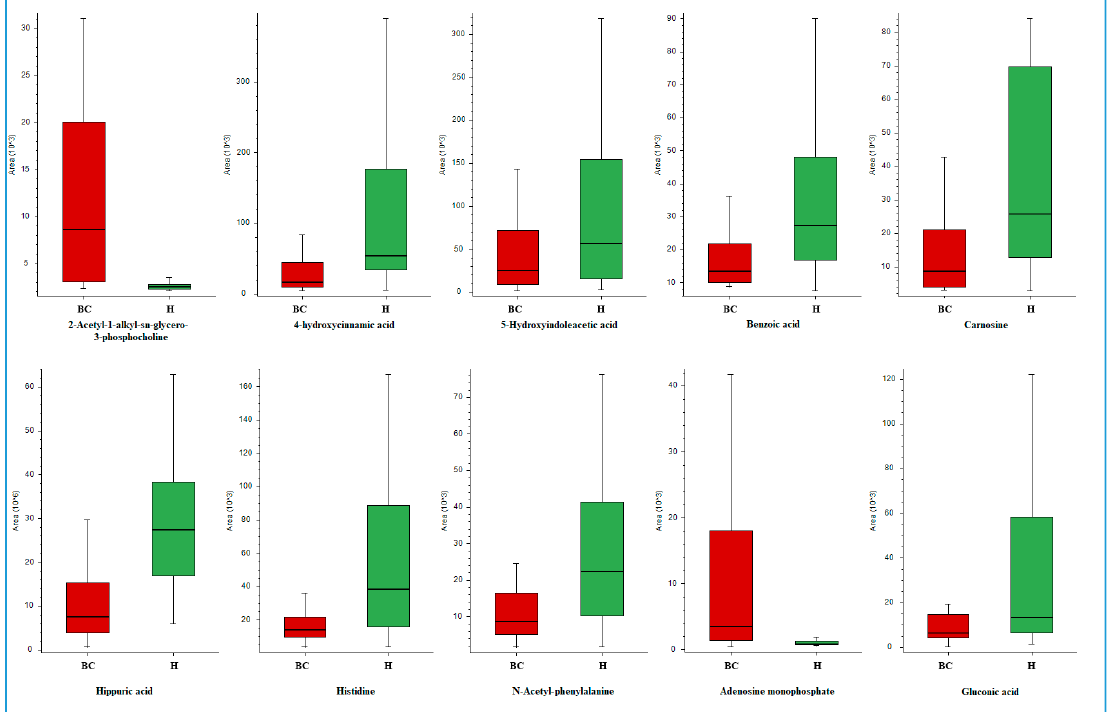
Figure 2. Box Whisker charts for selected compounds differentiating the studied groups (red (BC)—bladder cancer patients, green (H)—healthy volunteers).